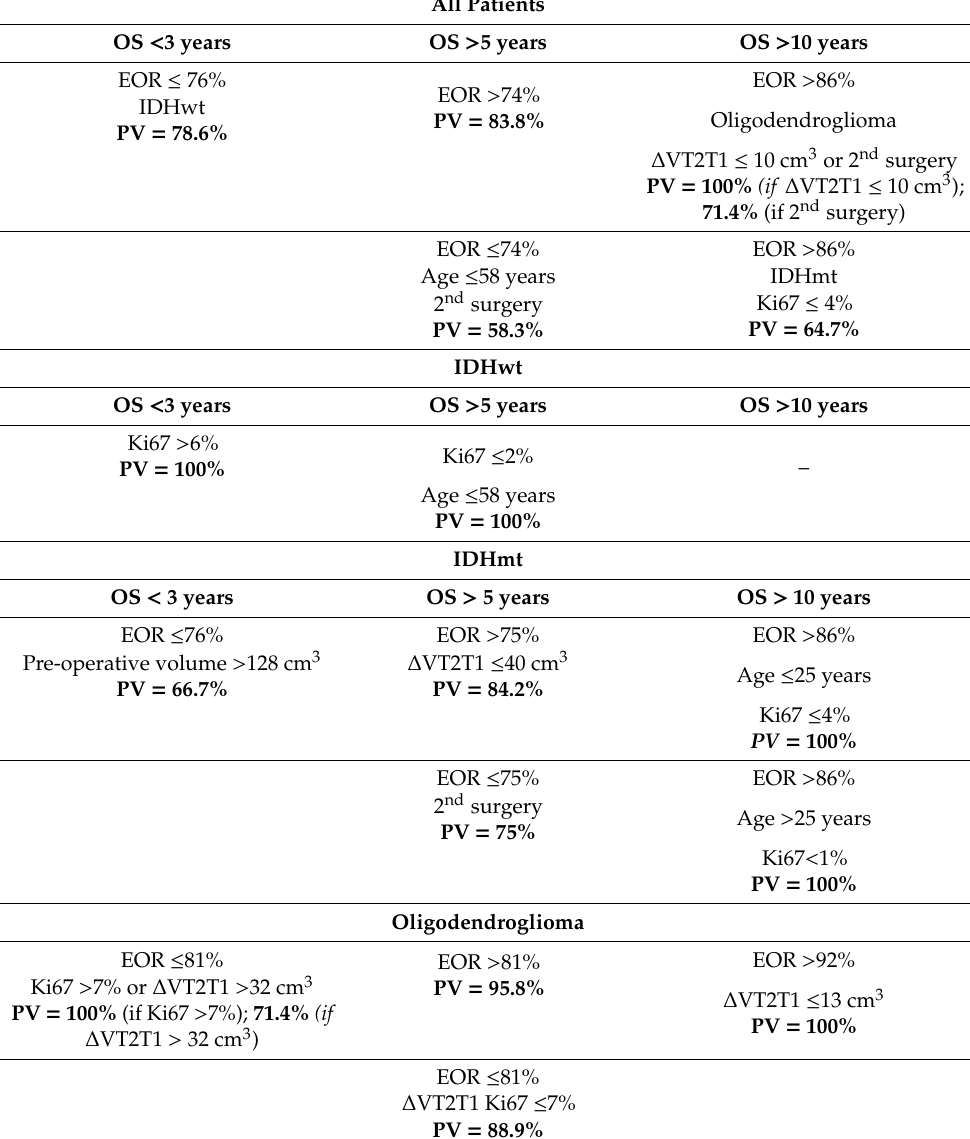
Table 5. Schematic representation of the principal features, derived from the decision tree analysis, that characterize homogeneous groups of patients in terms of prediction of OS < 3, > 5, and > 10 years, respectively. In each cell are indicated the features of the subgroup and the predictive value (PV). The analyses were conducted on the whole cohort of patients (see Figure 2) and separately on the three molecular classes (see Figure 3): astrocytomas, IDH wildtype (IDHwt); astrocytomas, IDH